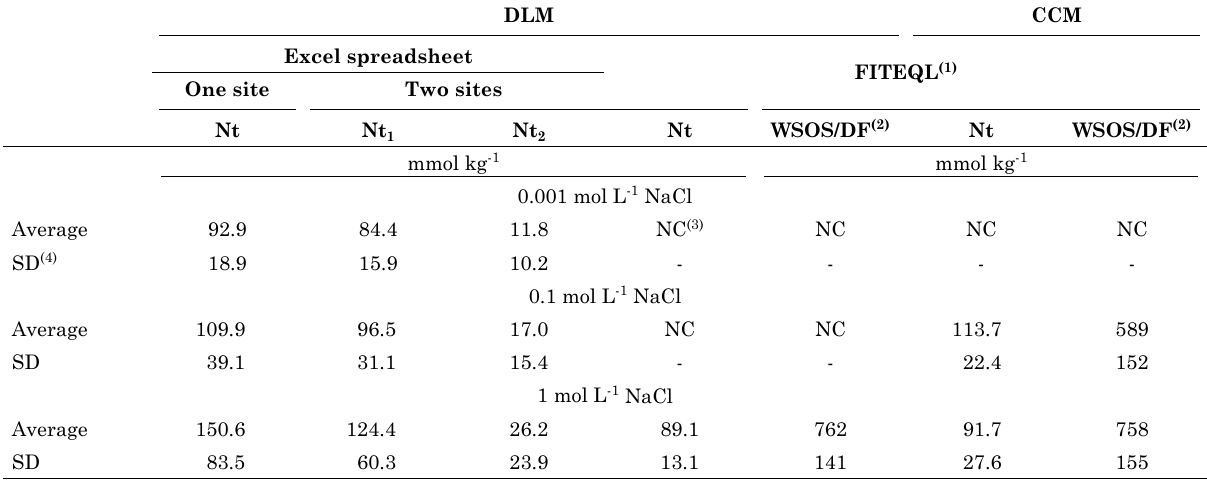
table 3. Site concentration (nt) from 17 brazilian oxisols using the diffuse layer model (dlm), estimated by hand calculation in excel spreadsheets, and by using the constant capacitance model (ccm), estimated by fiteQl